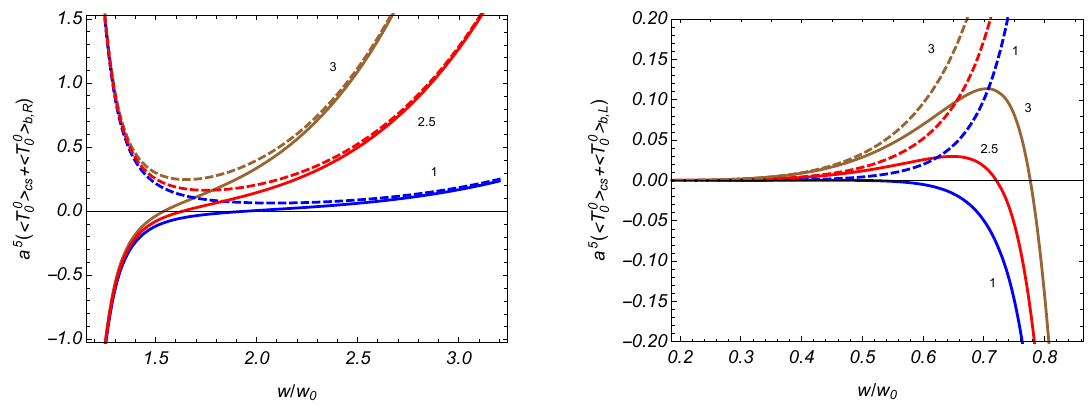
Figure 5 . The dependence of the cosmic string and brane-induced contribution in the VEV of the energy density on the ratio w/w 0 for different values of the parameter q (numbers near the curves). The full and dashed curves correspond to the fields with s = +1 and s = plotted for ma = 1, α 0 = 0 . 3, r/w 0 = 0 .